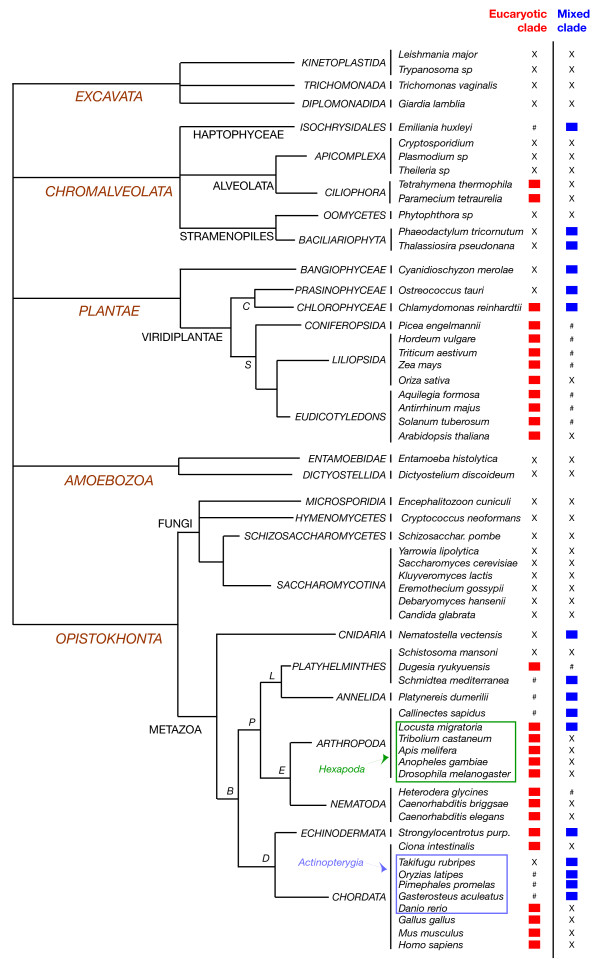
Phyletic distribution of the eukaryotic class 4 HDACs. Most of the species in which we sought class 4 HDACs are shown, together with our current view of their phylogenetic relationships [12]. The nomenclature used for the phylogenetic groups is according to Simpson and Roger [12] and the NCBI website. In each case in which the genome of a species has been fully sequenced, we indicate the presence or absence of a "eukaryotic group" or "mixed group" class 4 HDAC. The # symbol denotes species for which only EST data are available. In these cases, our failure to find a class 4 HDAC of one type of the other does not mean that none exists. In the case of the fungi, we searched against the genomic data of all species available on the NCBI website and failed to find a class 4 HDAC in any of them. 'Phytophthora sp' are Phytophthora sojae + Phytophthora ramorum; 'Plasmodium sp' are Plasmodium berghei + Plasmodium chabaudi + Plasmodium vivax + Plasmodium yoelii yoelii; 'Trypanosoma sp' are Trypanosma cruzi + Trypanosma brucei.